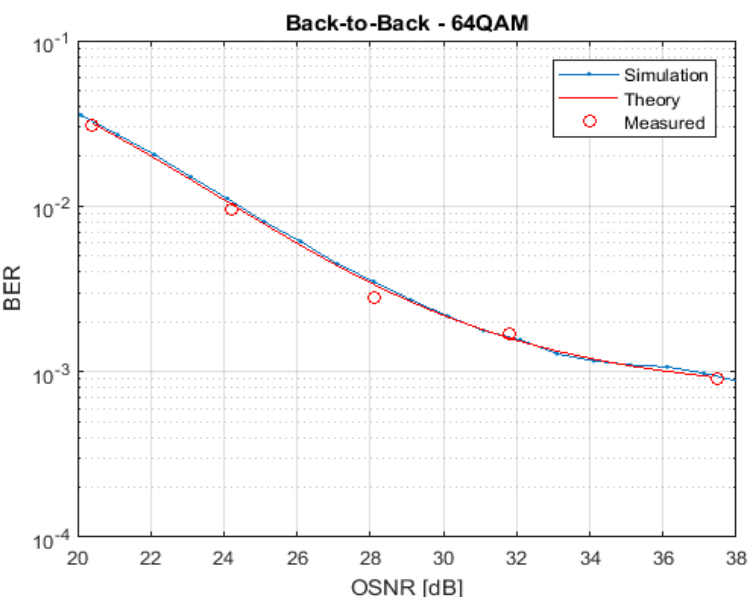
Figure 2. Experimental and theoretical back-to-back performance of a 64-QAM transmitter versus optical signal-to-noise ratio (OSNR).